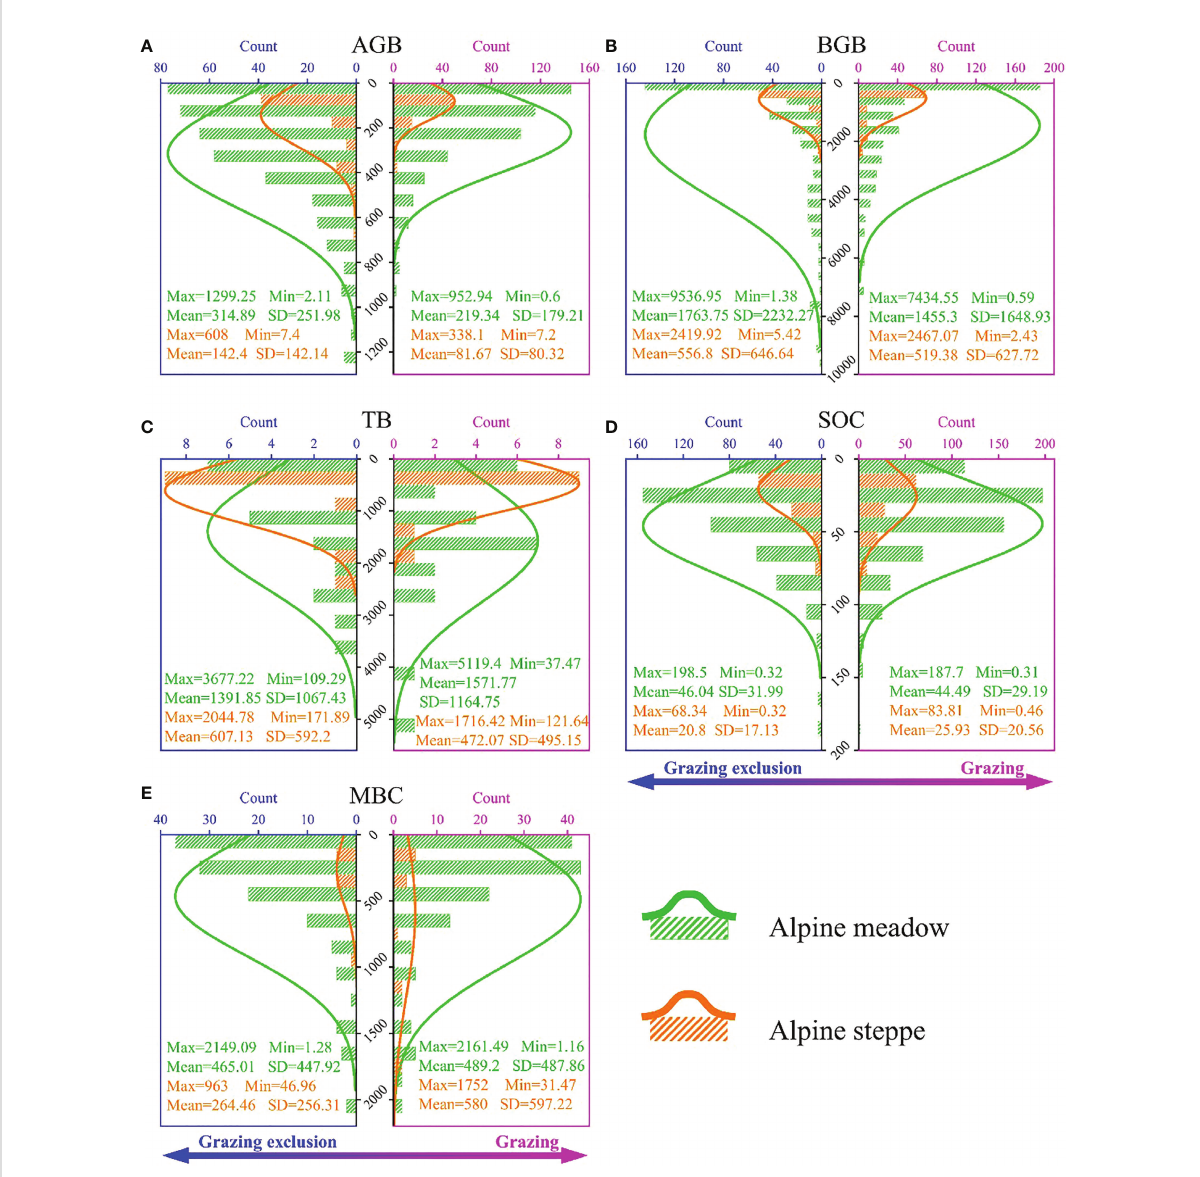
FIGURE 1 Count distributions of (A) aboveground biomass (AGB), (B) belowground biomass (BGB), (C) total biomass (TB), (D) soil organic carbon (SOC) and (E) microbial biomass carbon (MBC) in the “ grazing ” and “ grazing exclusion (GE) ” group across alpine steppe and meadow. “ Max ” , “ Min ” , “ Mean ” and “ SD ” represents the maximum value, the minimum value, the average value and the standard deviation,